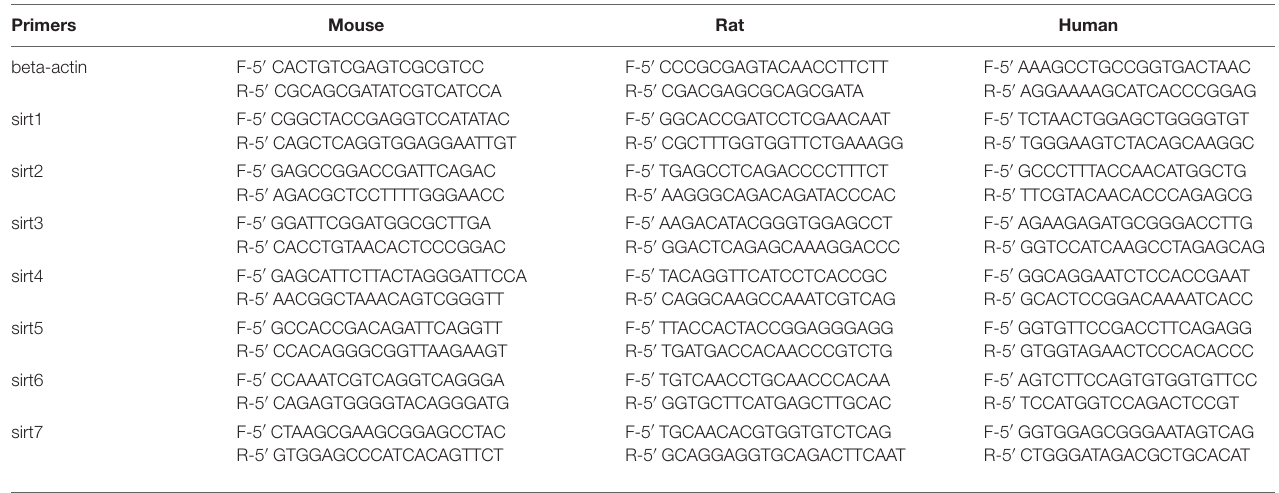
TABLE 1 | Primers used in the study.